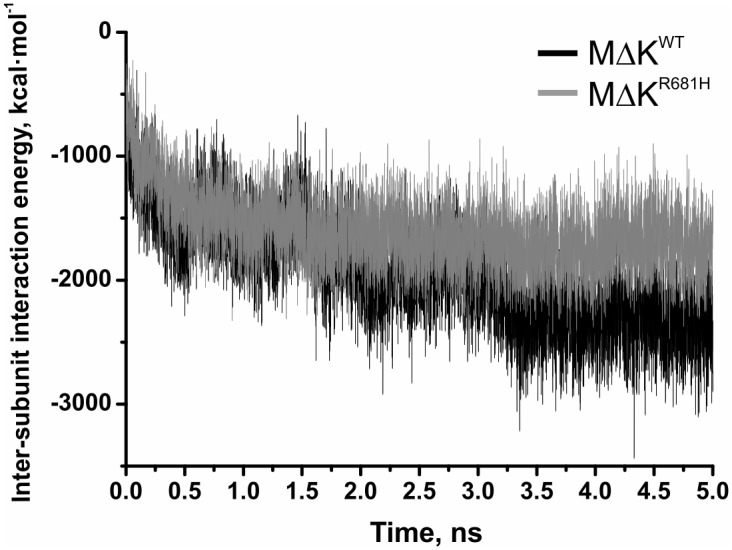
Inter-subunit interaction energies during molecular dynamics simulations.Interaction energies are calculated as Eq 1 and represented by black line in case of PfCCT MΔKWT and by grey line in case of PfCCT MΔKR681H, respectively.